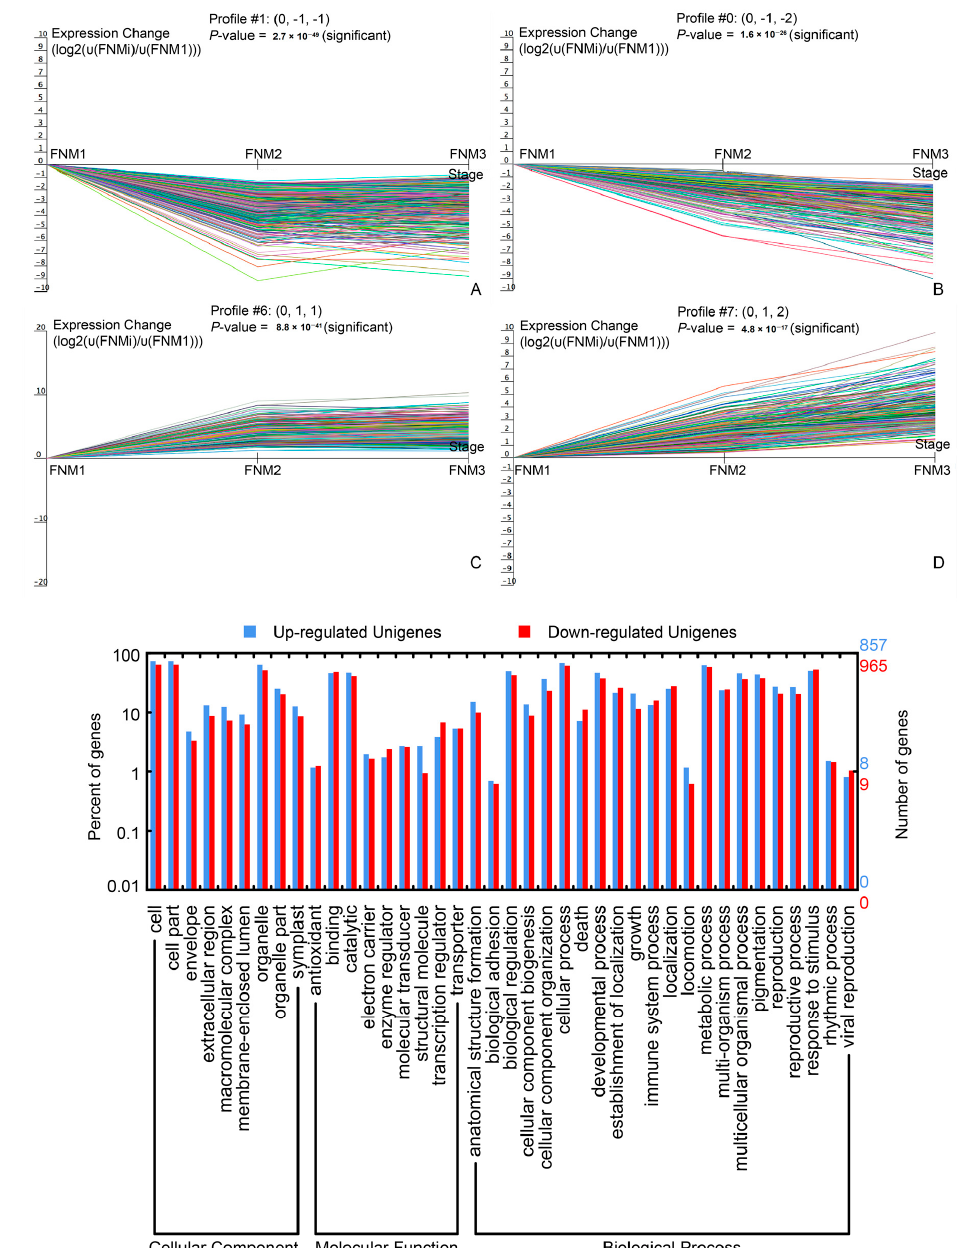
Figure 5. Significant DEG expression profiles ( A – D ) and their GO classification ( E ) in female fertile ovules. Profile 1 ( A ) and profile 0 ( B ) indicates a down-regulated trend and profile 6 ( C ) and profile 7 ( D ) indicates an up-regulated trend from FNM1 to FNM3 stage. GO analysis for these unigenes was shown ( E ). The down-regulated unigenes are union of profile 0 and profile 1. The up-regulated unigenes are union of profile 6 and profile 7.